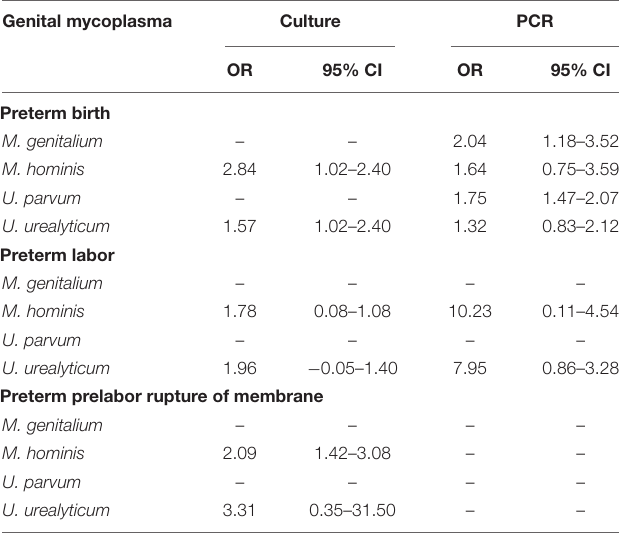
TABLE 1 | Subgroup analysis of the association (odds ratio) of genital mycoplasma with preterm birth (PTB), preterm labor (PTL), and preterm prelabor rupture of membranes (PPROM) based on the diagnostic method used to detect genital mycoplasma. Genital mycoplasma Culture